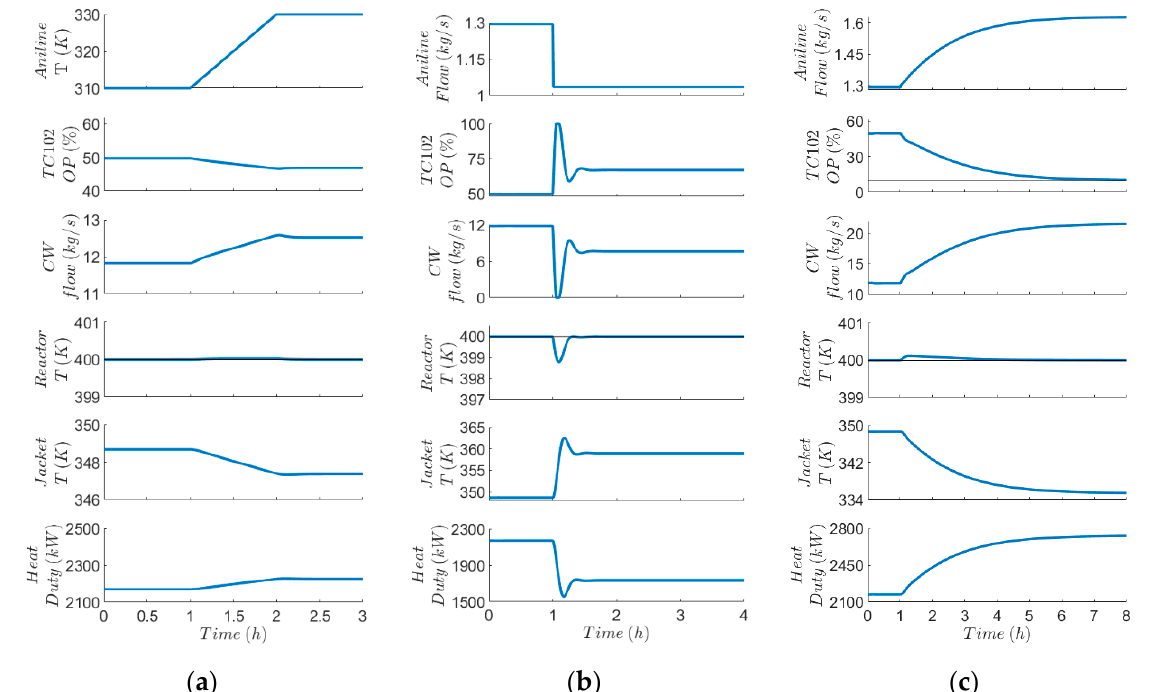
Figure 8. Control performance of plant Design A under ( a ) Scenario 1, ( b ) Scenario 2, and ( c ) Scenario 3.